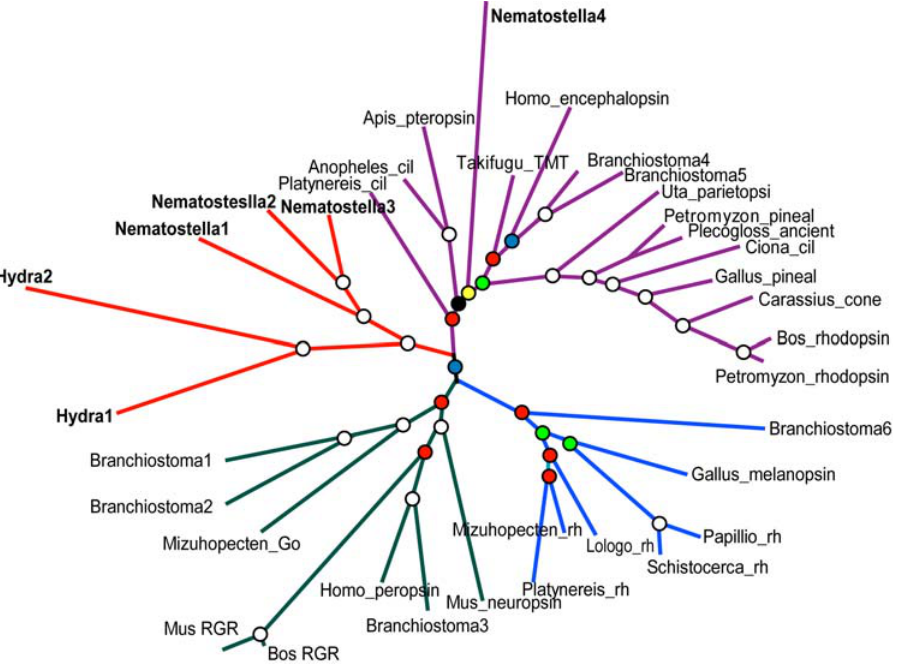
Figure 2. Unrooted metazoan-wide phylogeny of opsins, new cnidarian genes in bold, branches proportional to substitutions per site. Circles at nodes indicate Bayesian posterior probabilities (White=1.0, Red . 0.90, Blue . 0.80, Green . 0.70, Yellow . 0.60, Black . 0.50). cil=ciliary, rh=rhabdomeric.